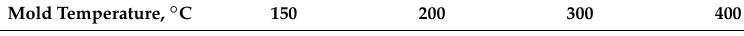
Figure 11. Fractographs of the composites thixoformed at mold temperatures of ( a ) 150 °C, ( b ) 200 °C, ( c ) 300 °C, and ( d ) 400 °C.